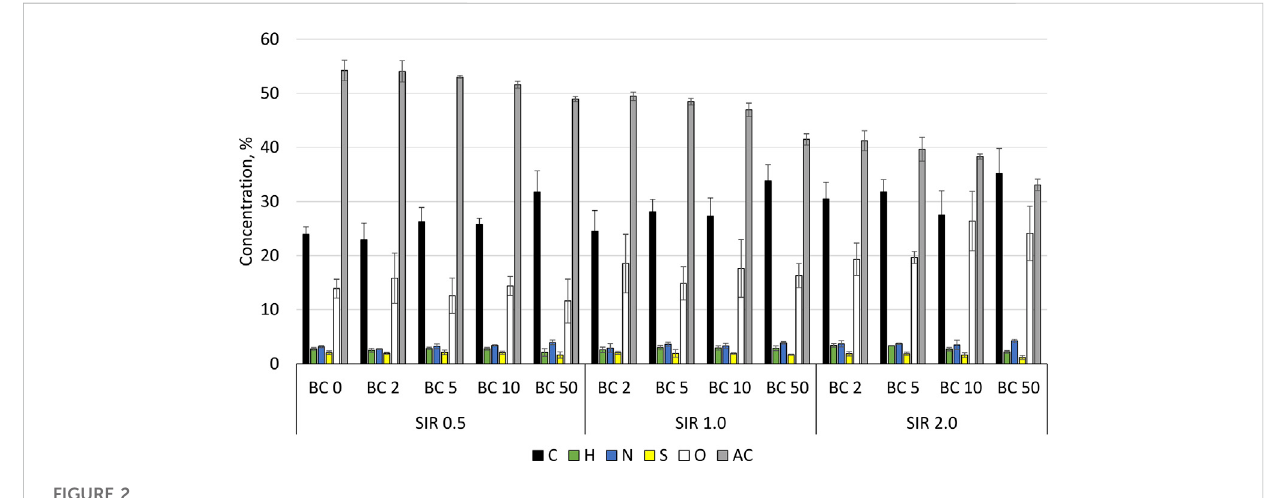
FIGURE 2 Elemental composition of process residues, as dry basis.